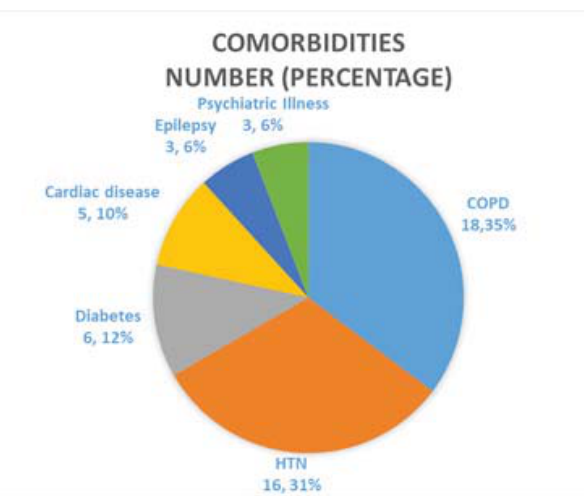
Figure 11. Region wise distribution of Burn